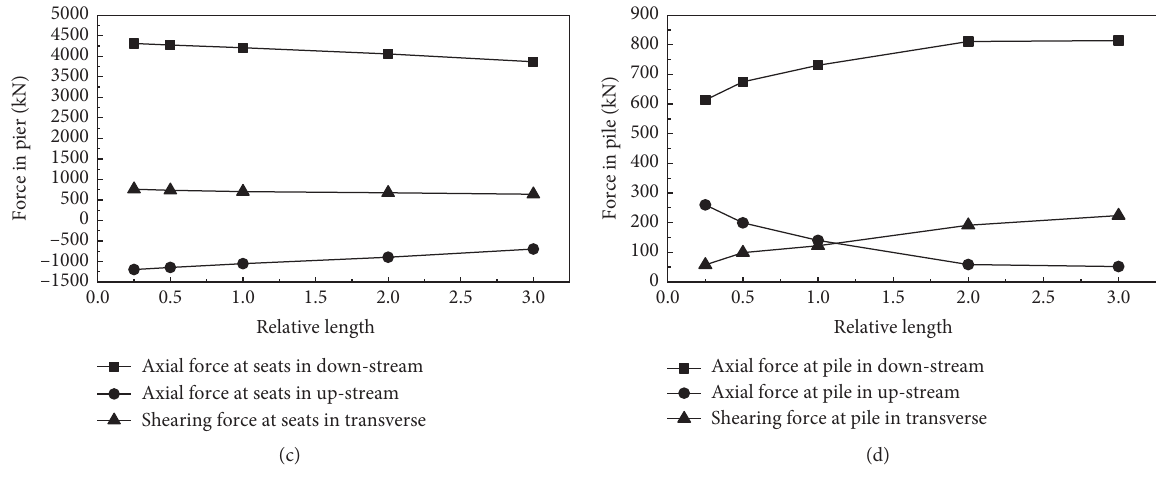
Figure 23: Variation of inner forces of structure and deflections with B . (a) Vertical force in bearings. (b) Displacement. (c) Internal force in piers. (d) Internal force in